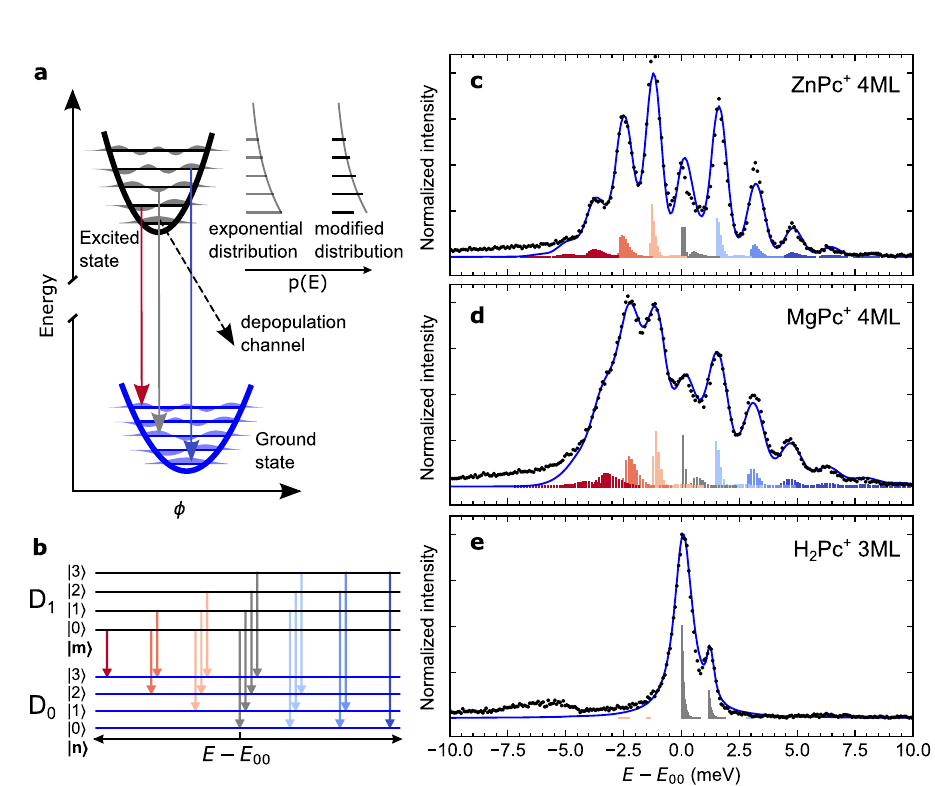
Fig.3|Schemeoftheelectron-libroncouplingmodeland fi ttingofthespectra. a Schemeoftheenergycurvesofgroundandexcitedstatesillustratingthelibronic verticaldownwardtransitions.Excited-statepopulationprobabilityisconsideredas exponential distribution or modi fi ed exponential distribution with suppressed probability of m=0 state. b Scheme of the lowest-energy libronic transitions coupledto theelectronicD 1 → D 0 transitionwithcoloursmatching thepeaksinthe panels c – e . c – e Comparisonofexperimental(blackdots)andsimulated(solidblue line) STM-EL fi ne spectra of Q + peak of ZnPc + and MgPc + ( c , d ) and Q y1 + and Q y2 + of